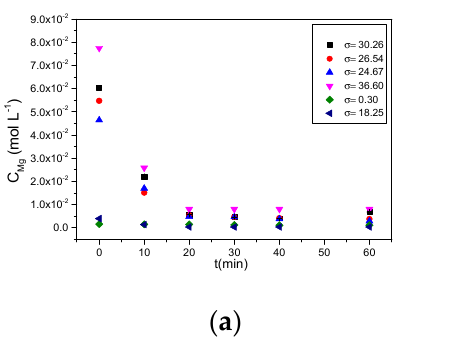
(filtrate of brucite suspension); ( a ) Magnesium concentration, C Mg and ( b ) pH as a function of time;